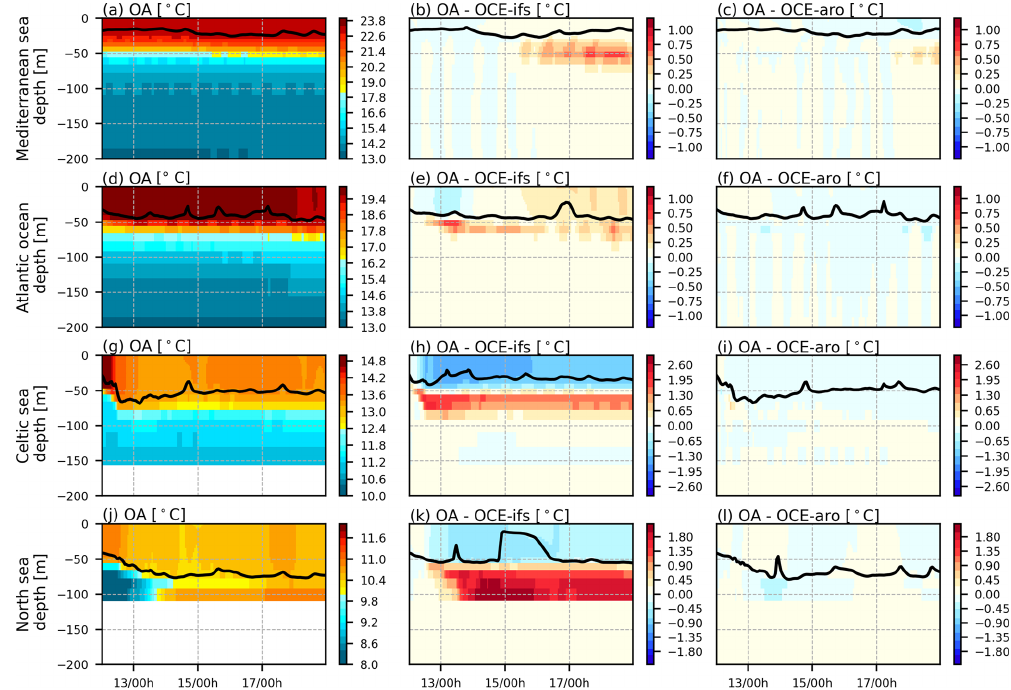
Figure 7. Temporal evolution of the mean vertical temperature profiles in the four zones (see Fig. 3d) simulated by the coupled (OA) simulation (a, d, g, j) and differences with the two forced ocean simulations (OA-OCE-ifs in b, e, h, k and OA-OCE-aro in c, f, i, l). The black lines delimit the averaged MLD of OA (a, d, g, j), OCE-ifs (b, e, h, k) and OCE-aro (c, f, i, l).